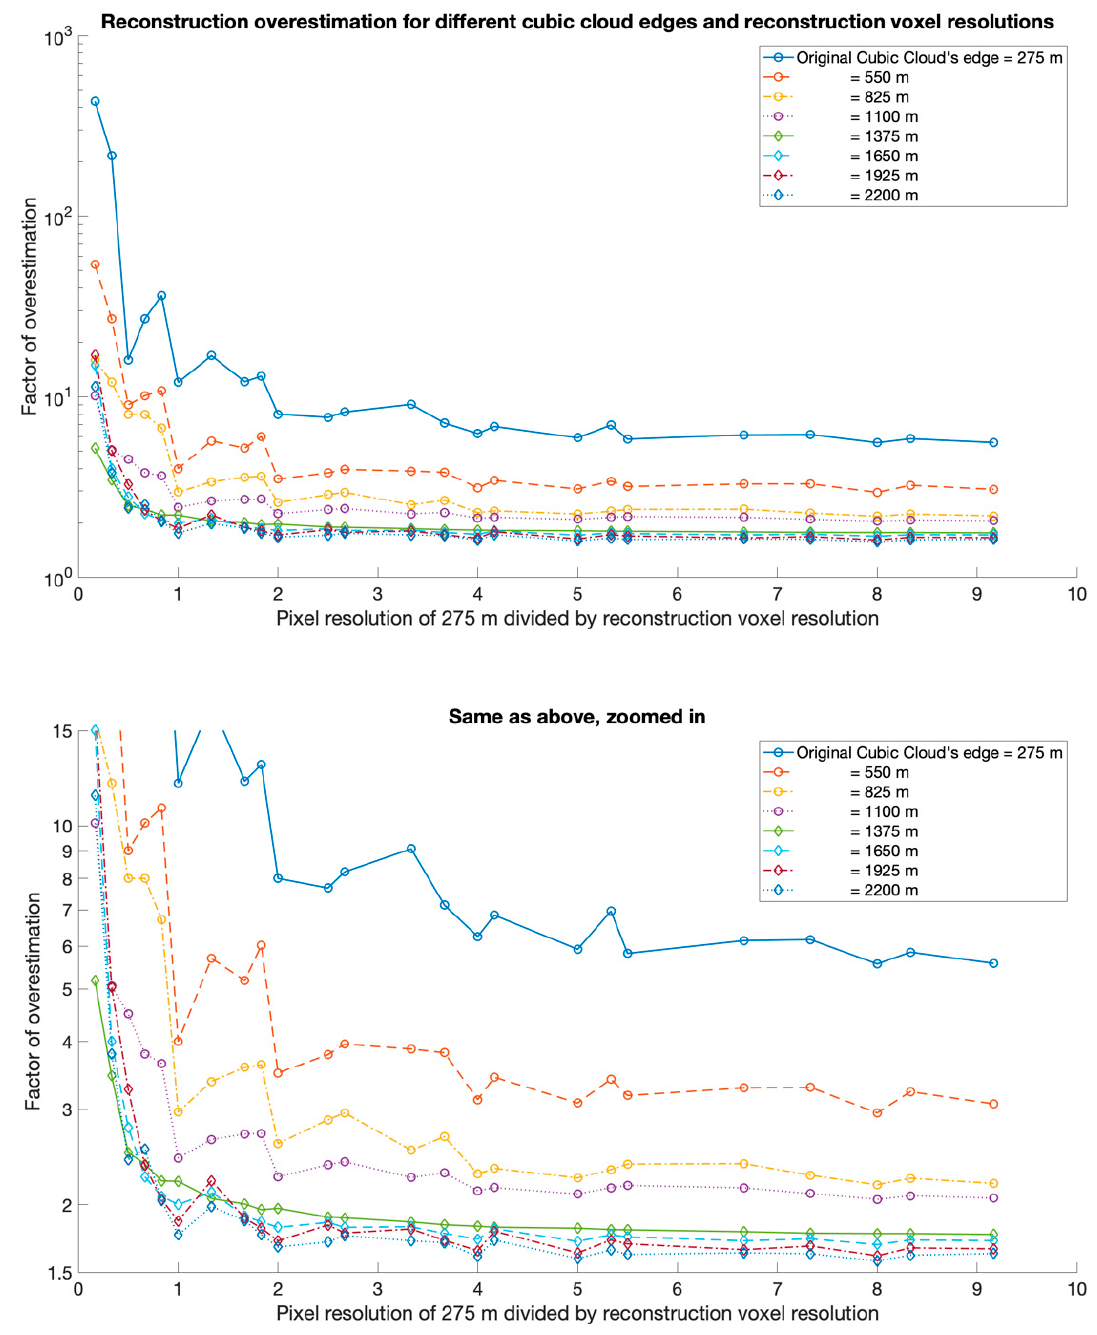
Figure 5. The factor of overestimation in cloud volume as a function of the ratio of image pixel resolution to the reconstruction voxel resolution. The vertical axes are in log scale. Different plots indicate different sizes of the original cubic cloud.